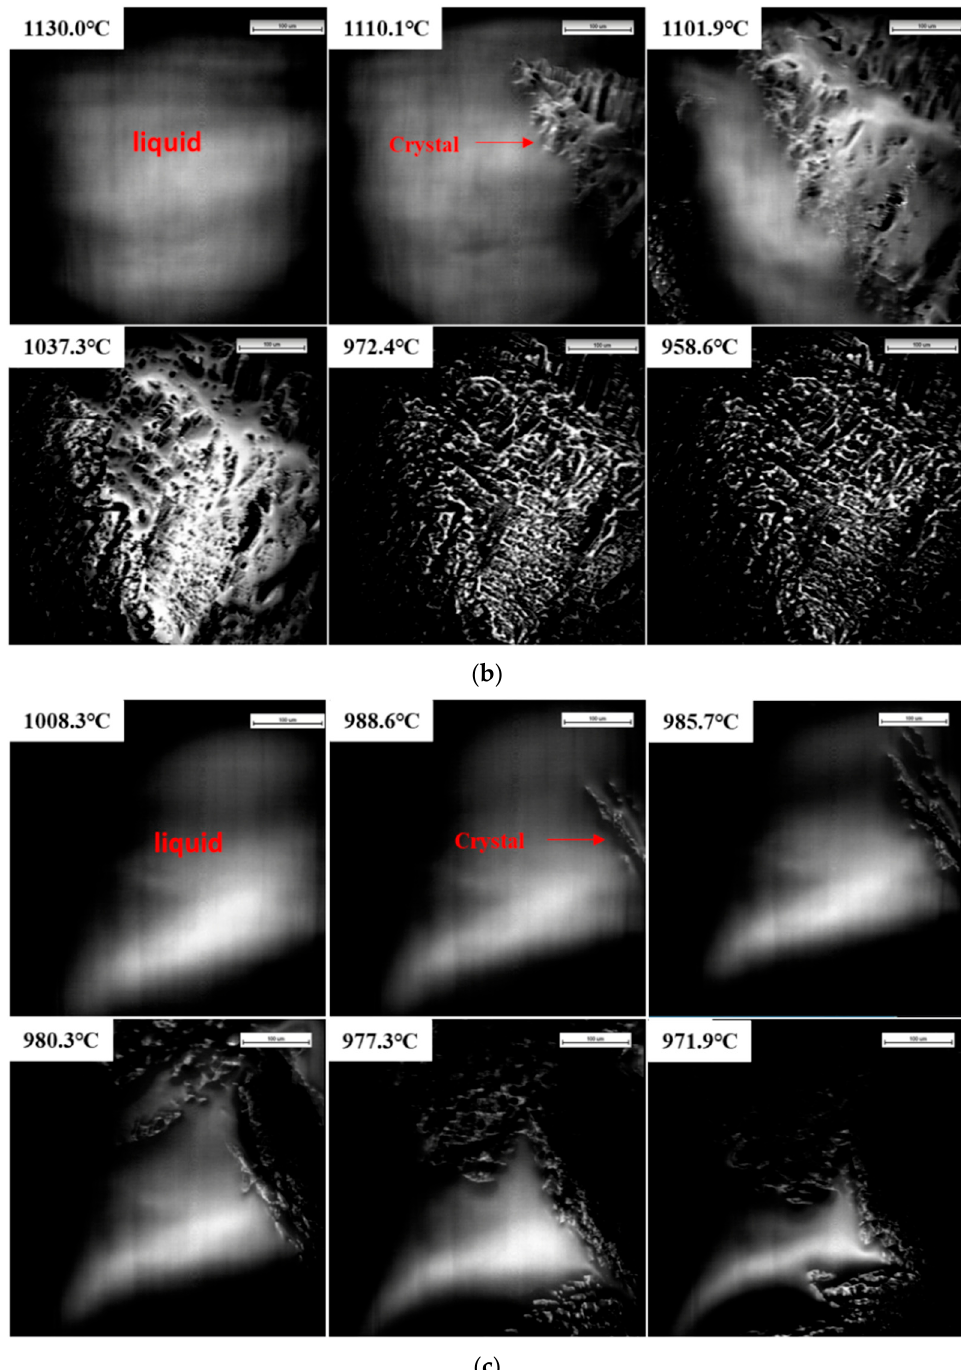
Figure 9. The crystallization process of the CaO–Al 2 O 3 -based mold flux measured by CSLM at different cooling rates: ( a ) 100 °C·min − 1 , ( b ) 300 °C·min − 1 , and ( c ) 500 °C·min − 1 .